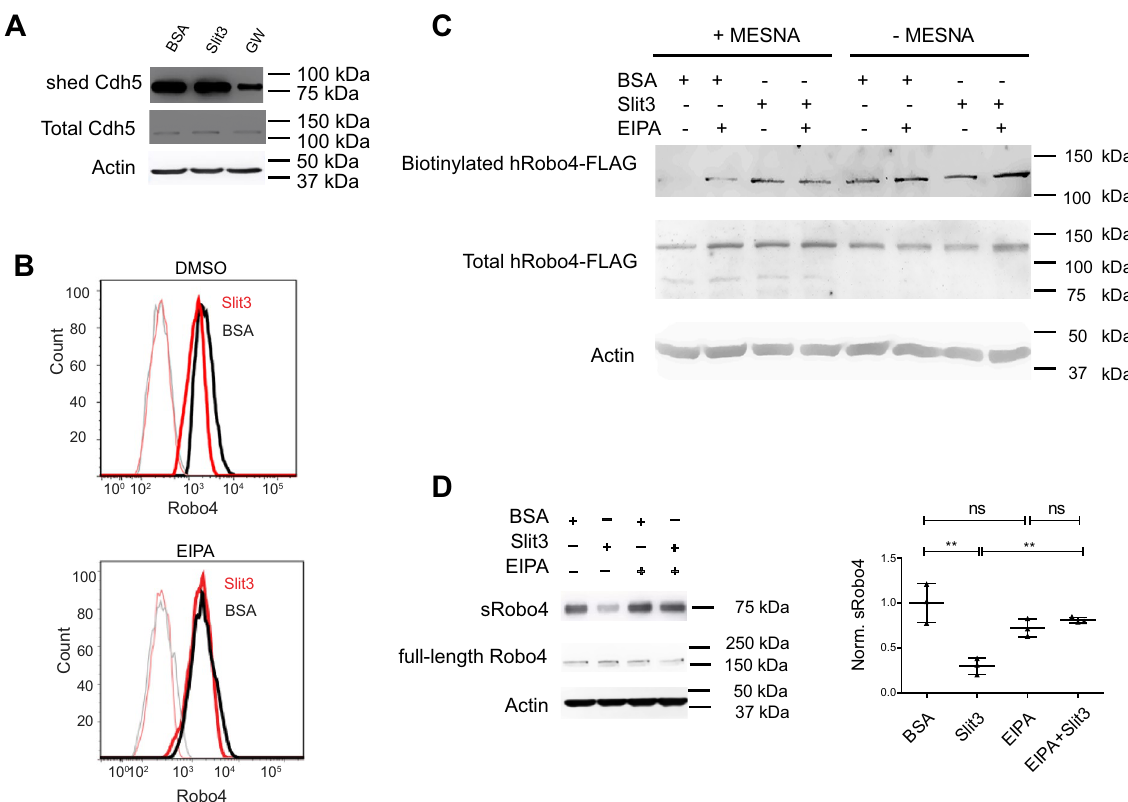
Figure 5. Slit3 down-regulates cell surface Robo4 and induces Robo4 internalization. ( A ) GW but not Slit3 reduced Cdh5 shedding. dECs in serum-free cultured were supplemented with BSA or Slit3 with or without GW, the duo-inhibitor for ADAM10 and ADAM. The conditioned media and cell lysate were probed with an anti-Cdh5 antibody in Western blot. ( B ) Slit3 reduced cell surface Robo4, and this was blocked by EIPA. Starved dECs were treated with Slit3 or BSA in the absence or presence of EIPA, and then cell surface Robo4 was assessed by flow cytometry after staining with an anti-Robo4 ectodomain antibody. Anti-Robo4 IgG and naïve IgG staining are drawn in heavy-bright and thin-faint lines, respectively, with corresponding colors. ( C ) Slit3 induced cell surface Robo4 internalization, and this was blocked by EIPA. After biotinylation of cell surface proteins at 4 °C, the hRobo4-HA-FLAG expressing dECs were treated with Slit3 or BSA in the absence or presence of EIPA at 37 °C. Cells were lysed immediately (total biotinylated protein preserved) or after MENSA treatment (MESNA cleaves uninternalized biotinylated protein), and biotinylated proteins were pulled down using streptavidin-coated beads. hRobo4-HA-FLAG were probed in western blot with anti-FLAG antibody. ( D ) Slit3 inhibited Robo4 shedding, and this was restored by EIPA. dECs were treated with Slit3 or BSA in the absence or presence of EIPA, and then sRobo4 in conditioned medium, and total Robo4 and actin in cell lysates were probed. sRobo4 was normalized to the total Robo4. The data represent 3 independent experiments and are presented as mean ± SD. The student’s t-test was performed for a two-group comparison. ns, not significant; *p < 0.05; **p <